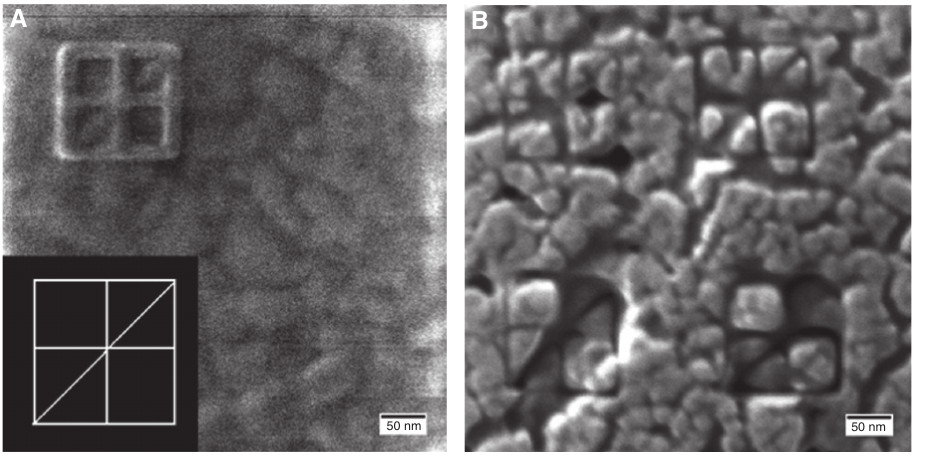
Figure 13 Ion lithography using the HIM. (A) Generation of nanoscale feature using He ion implantation. The surface has a 100-nm layer of gold on a Si wafer; He ion deposition occurred with 1 μ s dwell time and 10 repeats of the pattern. Inset is the pattern of deposition. (B) Ion milling using HIM, a 10-nm layer of AuPd sputter coated on a Si wafer. Pattern same as in (A) with different dwell times, starting from top left and going in a z pattern: 5 μ s, 10 μ s, 15 μ s, and 20 μ s dwell times with one repeat and milling